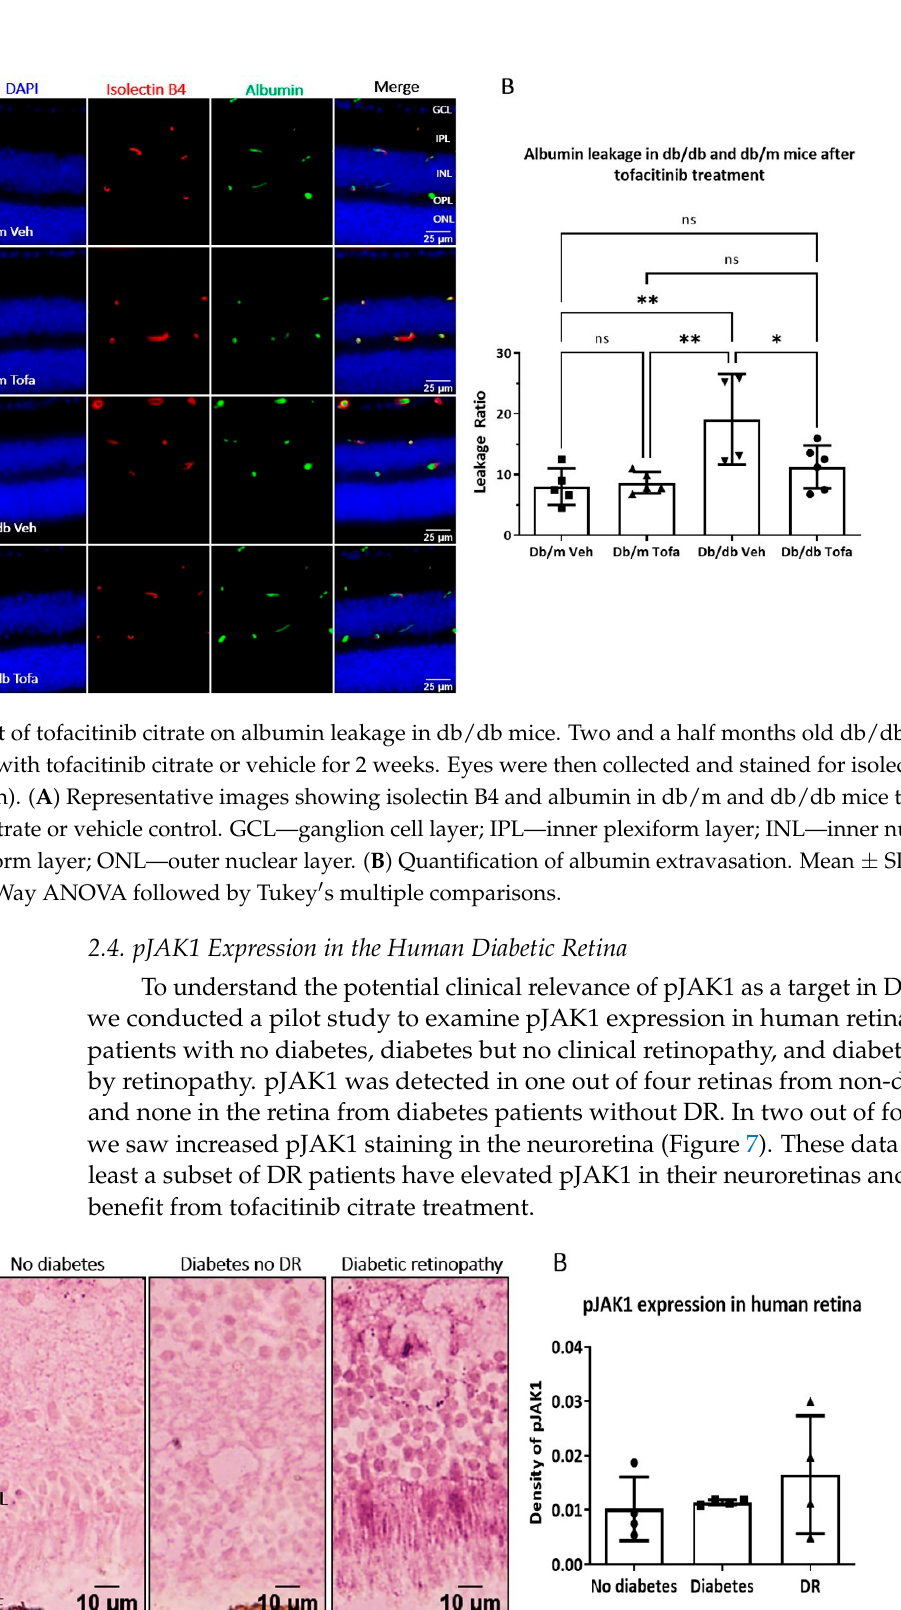
Figure 7. The expression of pJAK1 in human DR retinas. Retinal sections from non-diabetes, diabetes without retinopathy and diabetes with retinopathy were stained for pJAK1 (purple) and imaged by light microscopy. ( A ) Representative images from n = 4 patients per group, showing immunohistochemistry for pJAK1 in different groups of retinas. ( B ) Quantification of the density of pJAK1 in human retinas from different groups. Mean ±